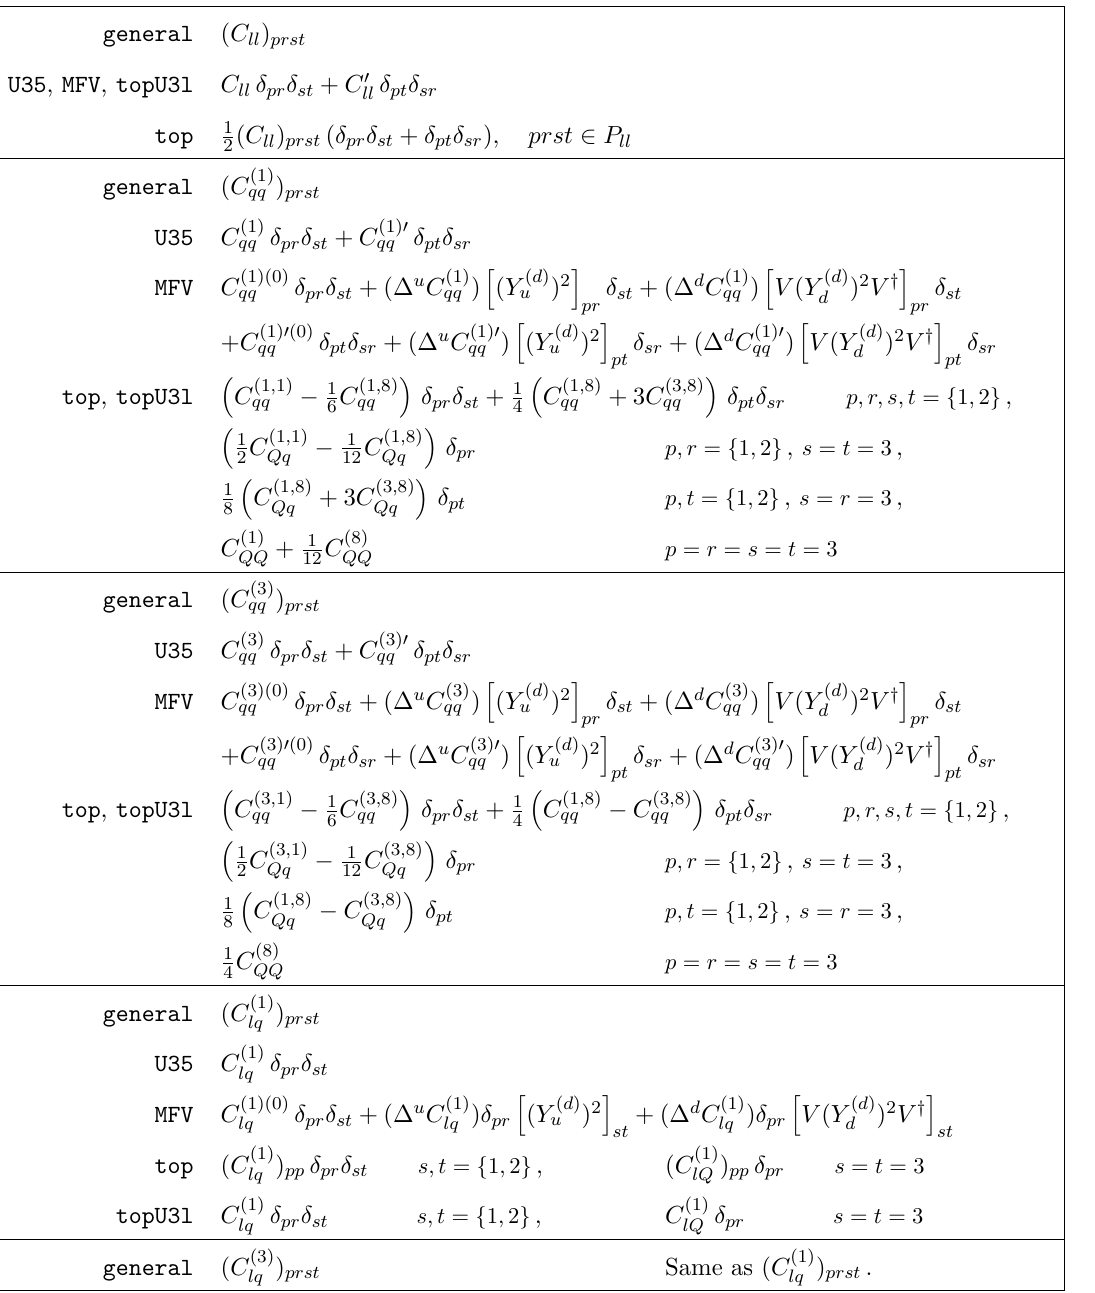
Table 12 . Conversion table among the 5 flavor assumptions considered, for the operators in L (8 a ) The set P is defined in eq. ll